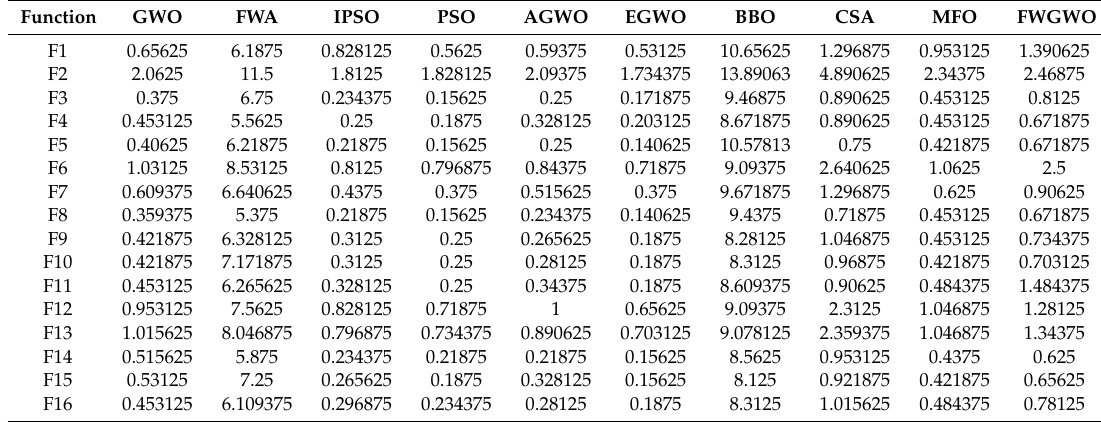
Table 3. Running time (seconds) of di ff erent algorithms.